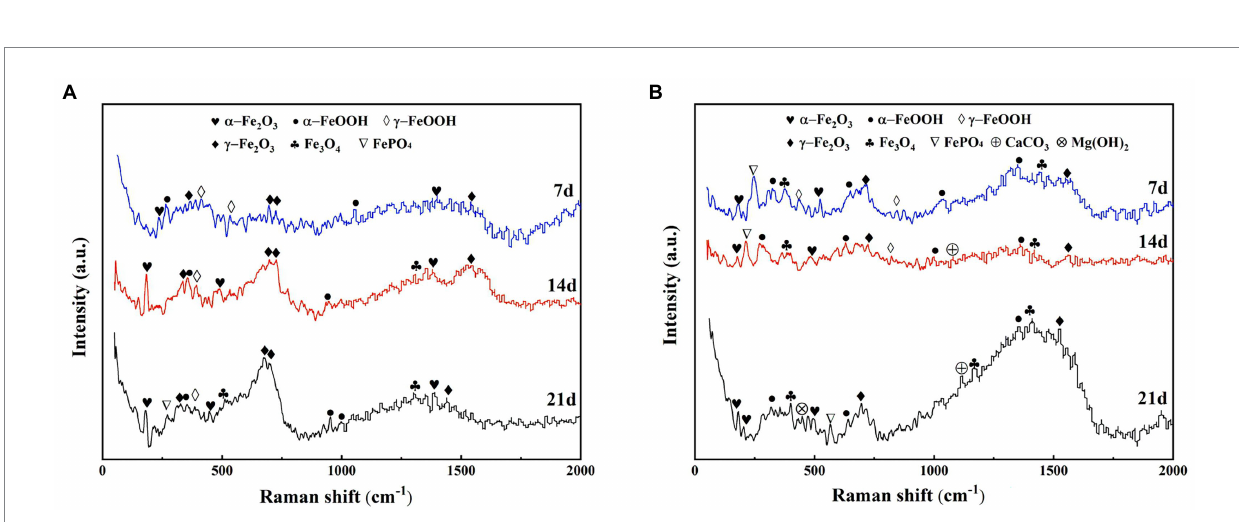
FIGURE 4 Raman spectra of corrosion products of X65 steel immersed in (A) sterile and (B) Alcaligenes sp. media for different periods.